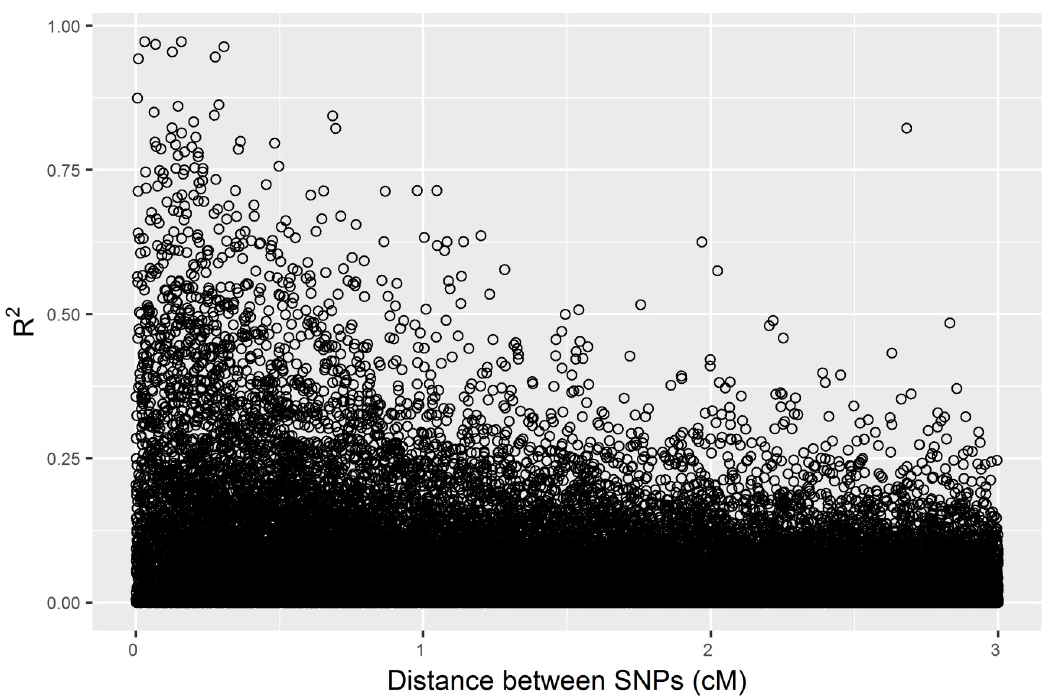
Fig 4. Plot of the squared correlations of allele frequencies ( R 2 ) versus distance in cM between closely located SNPs in a panel with 7K SNPs across 150 cM linkage map.